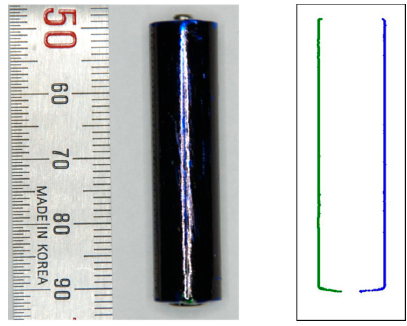
Figure 8. Picture of “AAA” type battery and image process result.